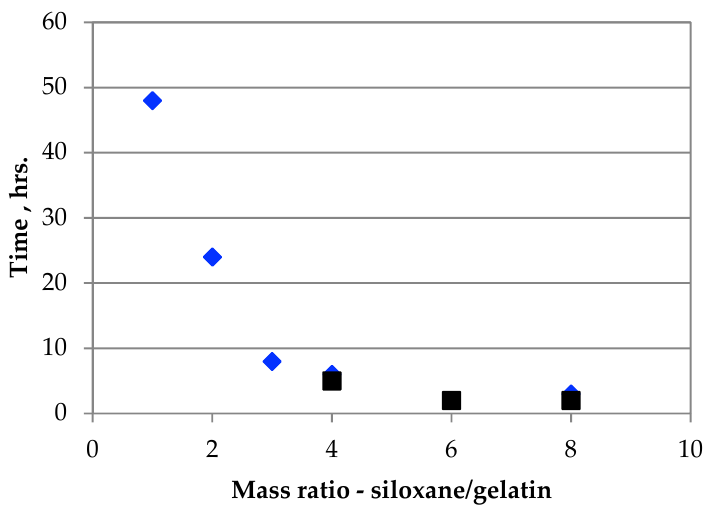
Figure 9. Effect of contact time on the pH of solutions during adsorption of Cu(II) ( ◆ ), Pb(II) ( ◼ ) and Cd(II) ( ▲ ) by hybrid monoliths GS 2:1: initial Cu(II) concentration 10 ppm, mass of adsorbent monoliths 0.32 ± 0.02 g, initial pH 4 and temperature 23 ± 1